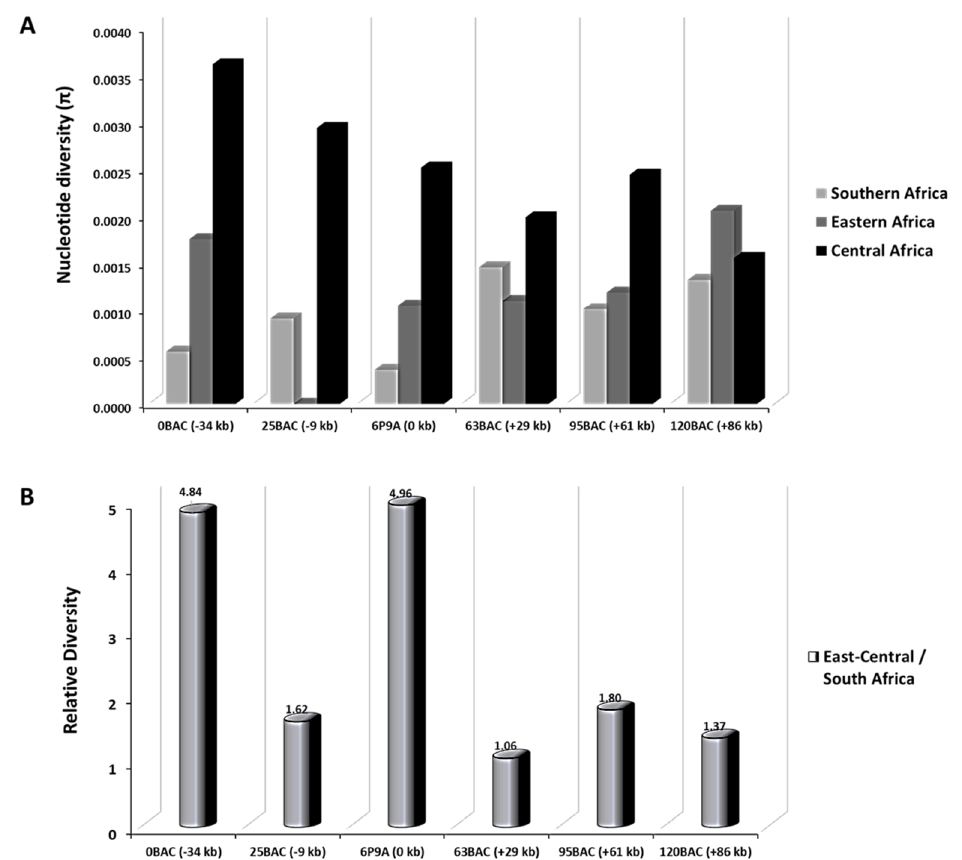
Figure 3. Nucleotide diversity survey at CYP6P9a and five loci around the pyrethroid resistance gene. For each locus, nucleotide diversity was investigated by sequencing A. funestus samples from seven sub-Saharan African countries. Results were further grouped samples into Southern, Eastern and Central Africa respective to mosquito field population origin. Positions (kb) of sequenced regions relative to CYP6P9a. ( A ) Levels of nucleotide diversity ( π ) for each African region. ( B ) Ratio of nucleotide diversity at each locus between Eastern-Central and Southern Africa.